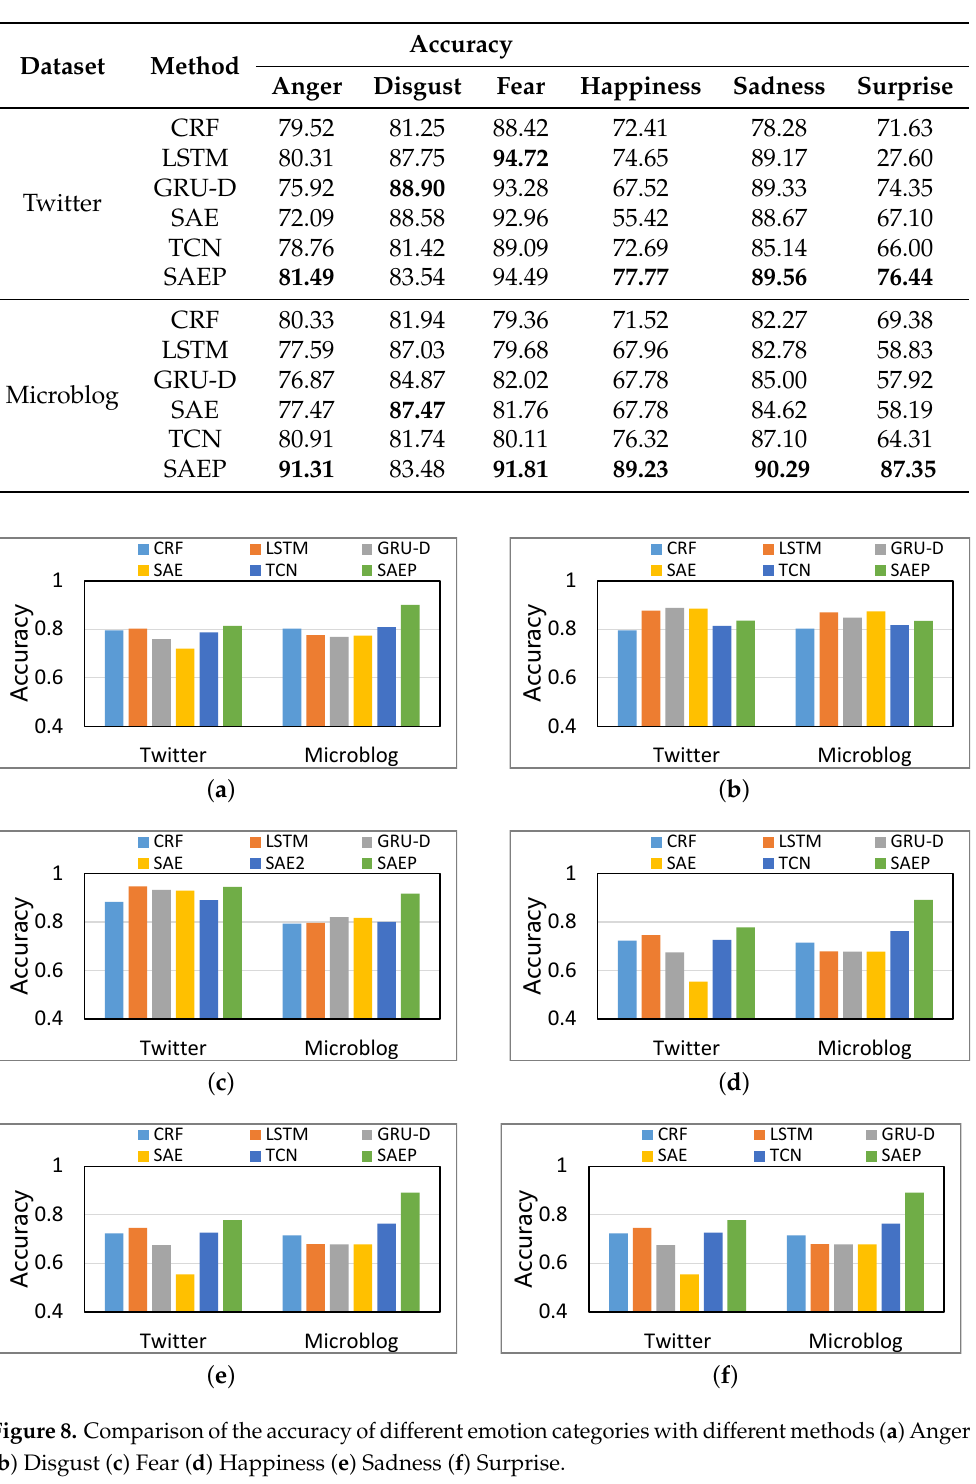
Table 2. Performance comparison of emotion prediction of SAEP with five baseline approaches on two datasets.